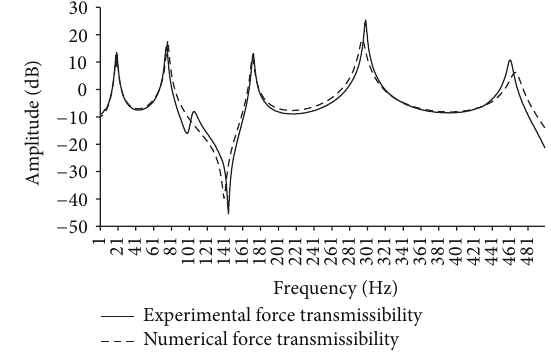
Figure 9: Experimental and numerical force transmissibility 𝑇 17,7